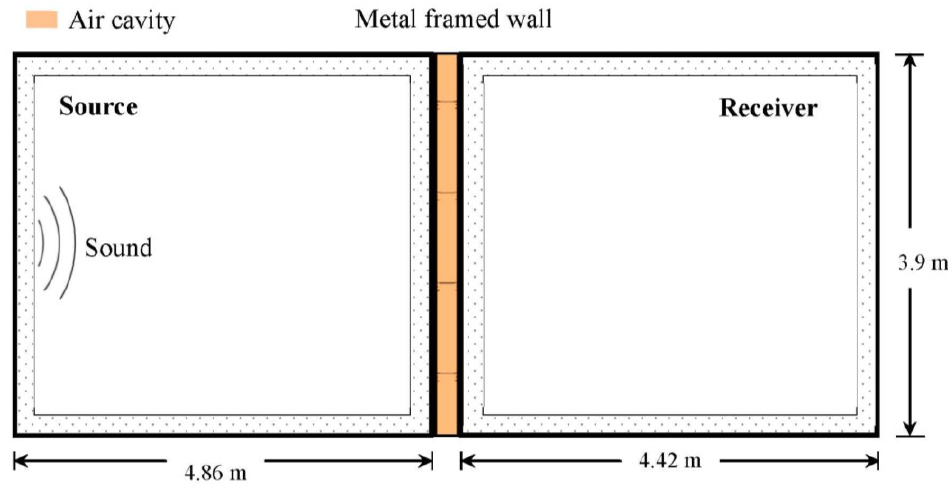
Figure 1. Two fluid-filled reverberation chambers partitioned using a metal-framed wall.